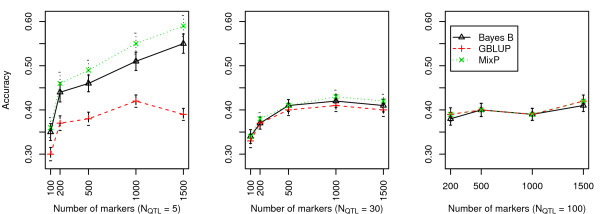
Comparison of accuracies of BayesB, GBLUP, and MixP with a heritability per chromosome = 0.01.